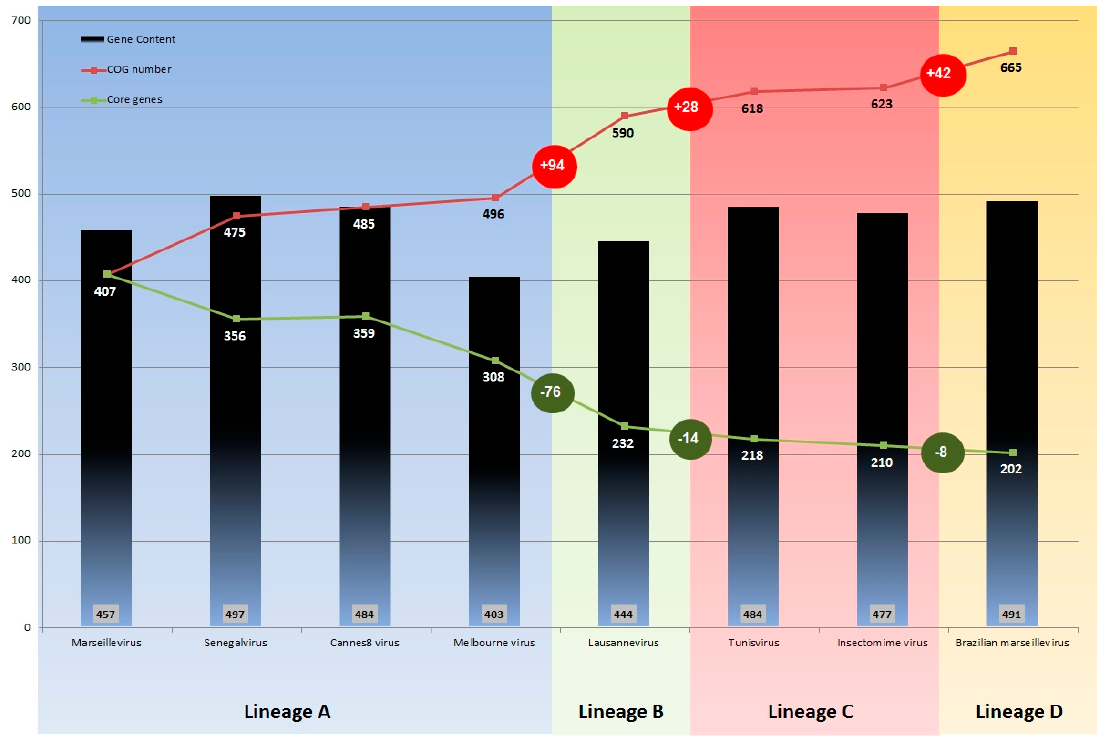
Figure 4. Pan-genome ( red line ) and core genome ( green line ) size of the Marseilleviridae family. Numbers into grey boxes refer to the gene number encoded by each virus strain. Numbers at line nodes represent the cumulative COG numbers after the inclusion of a new genome. Number in ( red and green ) circles demonstrate the variation of COGs after the inclusion of sequences from a different lineage. Colors on the graph identify viruses from the same lineage, alongside the proposed new lineage D consisting of BrMV.